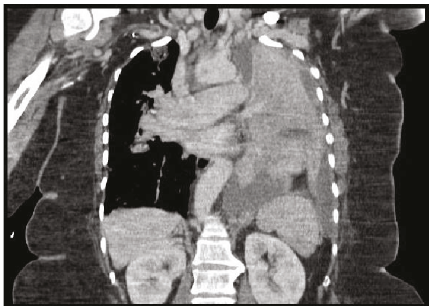
Figure 4: Coronal views with clear complete consolidation of the left lung, left pleural e ff usion, and worsening consolidative and nodular changes of the right